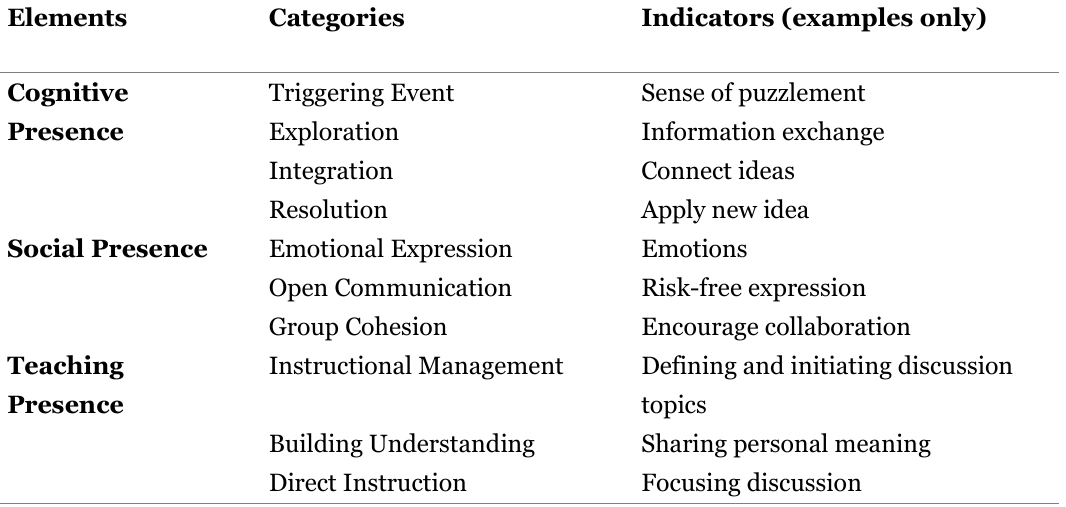
Community of Inquiry Coding Template Elements Categories Indicators (examples